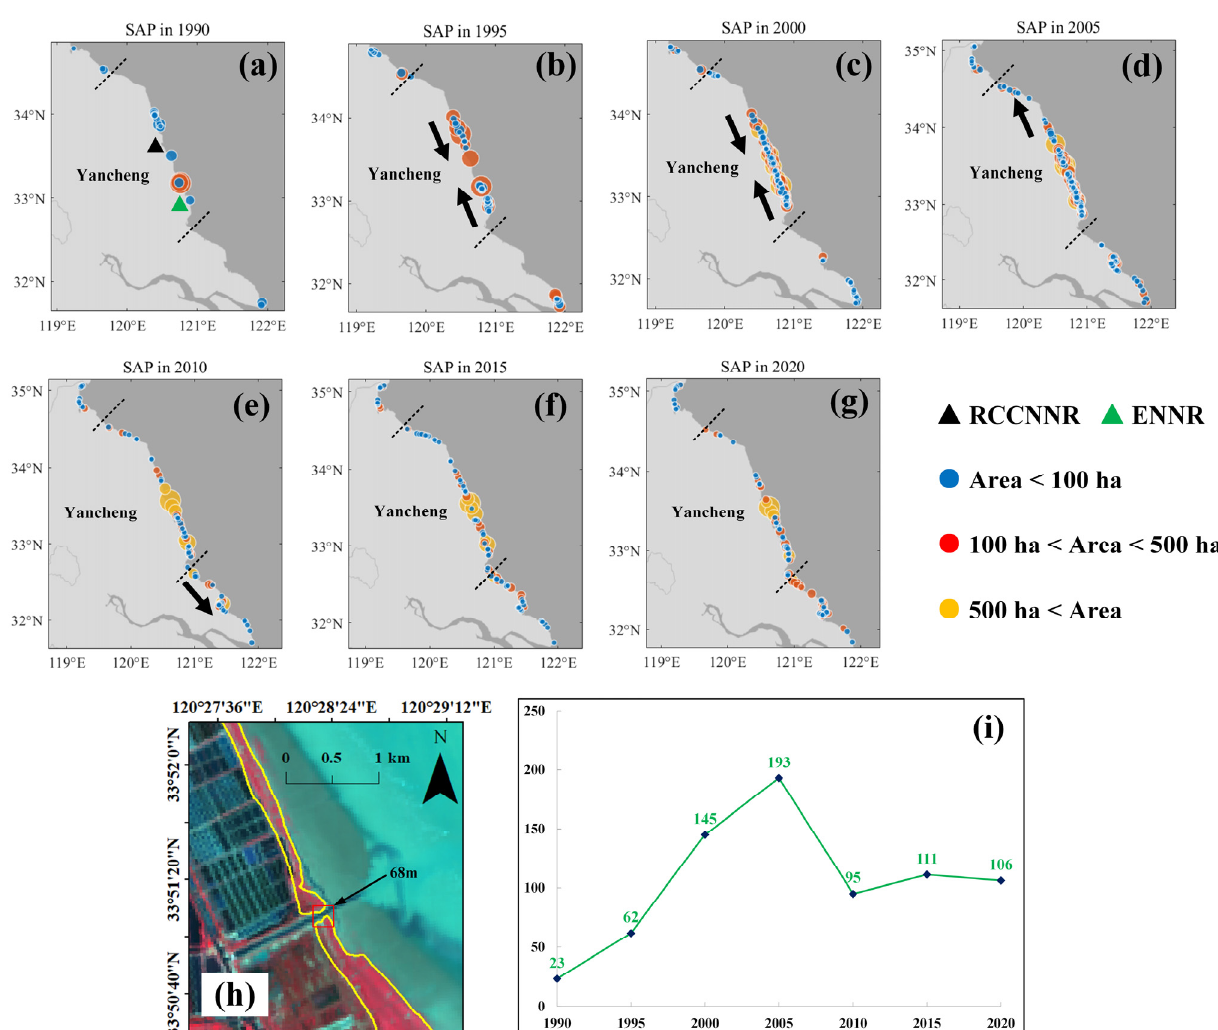
Figure 11. ( a – g ) Distribution of centroid of S. alterniflora patch (SAP) in Jiangsu from 1990 to 2020. There are three levels of patch area. ( h ) The yellow envelope is the patch boundary of S. alterniflora , and the distance between the two patches is 68 m. Combined images of NIR-R-G band. ( i ) Number of S. alterniflora patches in Jiangsu each year.